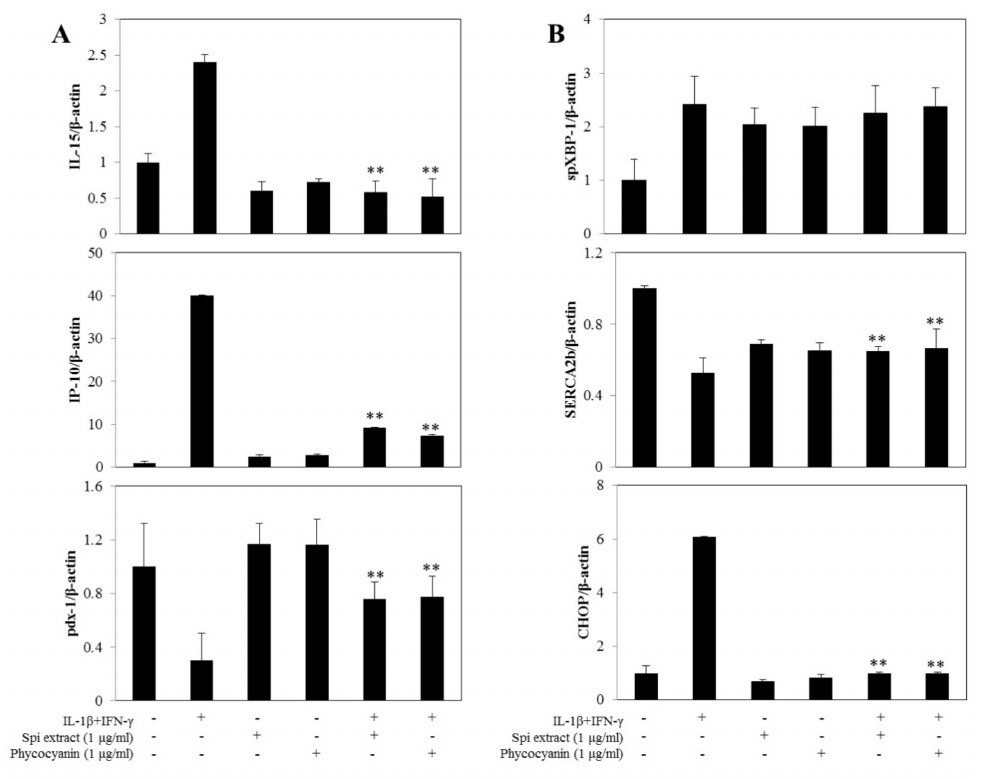
Figure 4. Spirulina extract modulates NF- κ B-dependent and ER stress marker gene expression. RINm5F cells were co-treated with Spirulina (Spi) extract or PC, and IL-1 β and IFN- γ for 24 h. ( A ) IL-15, IP-10, and pdx-1, and ( B ) spXBP-1 and SERCA2b mRNA expression levels were determined using real-time PCR; the housekeeping gene beta-actin was used to normalize the data. Each value represents